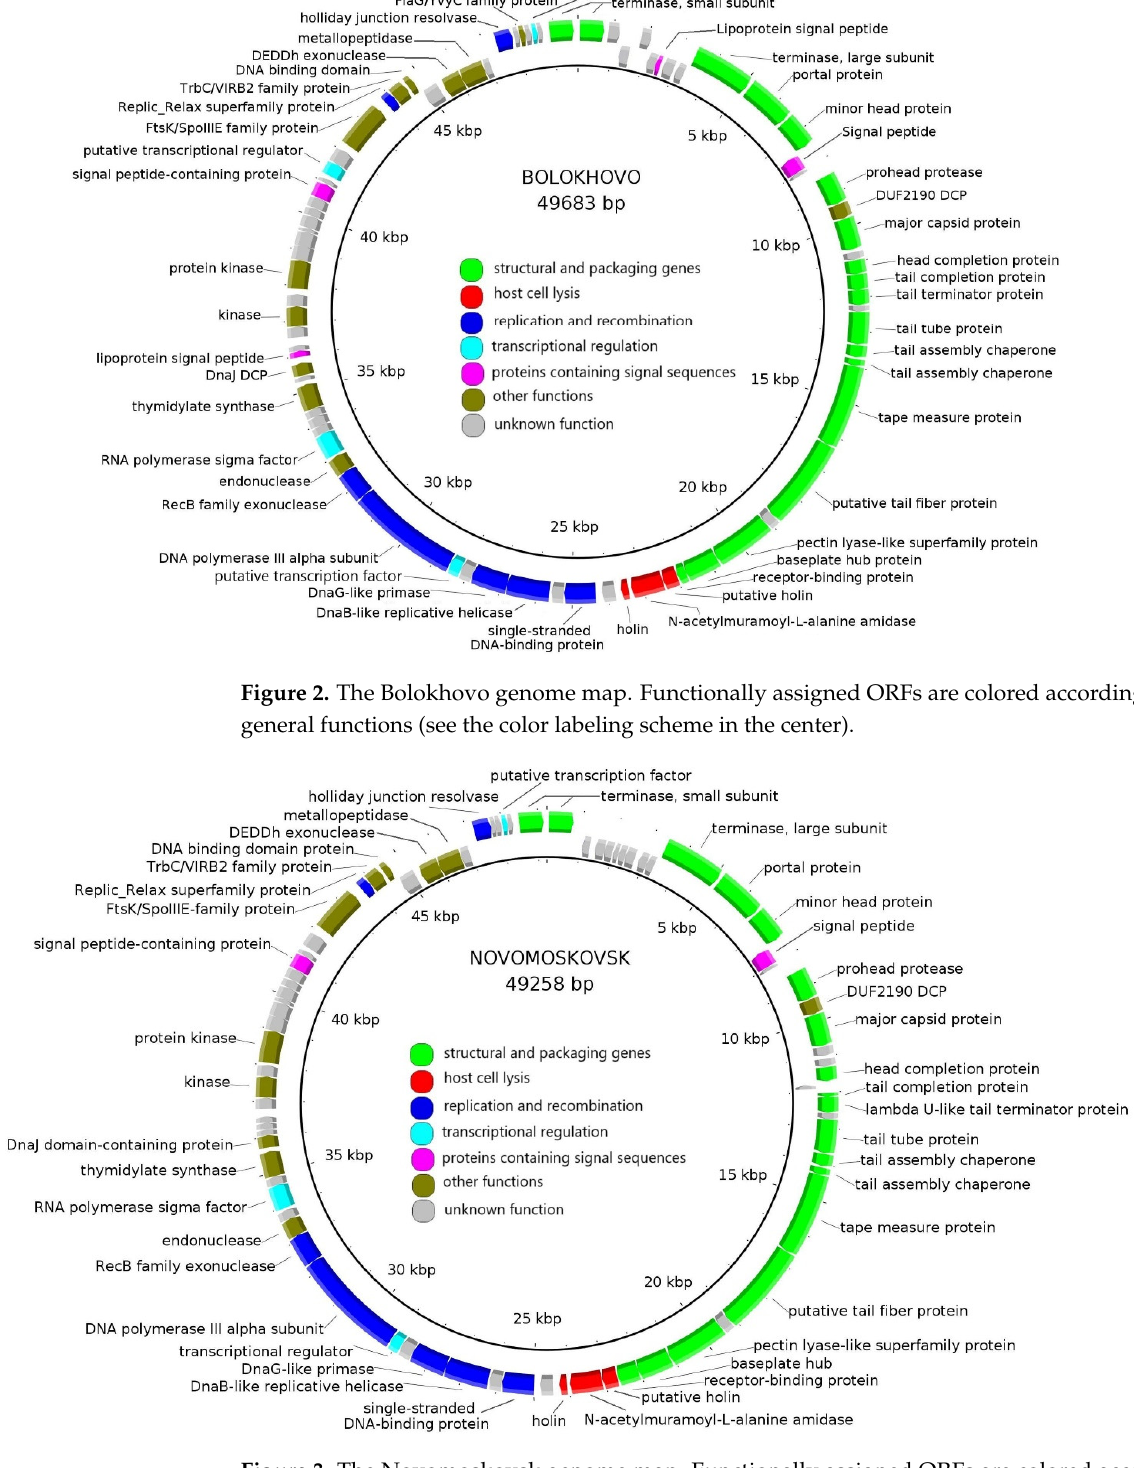
Figure 3. The Novomoskovsk genome map. Functionally assigned ORFs are colored according to their general functions (see the color labeling scheme in the center).